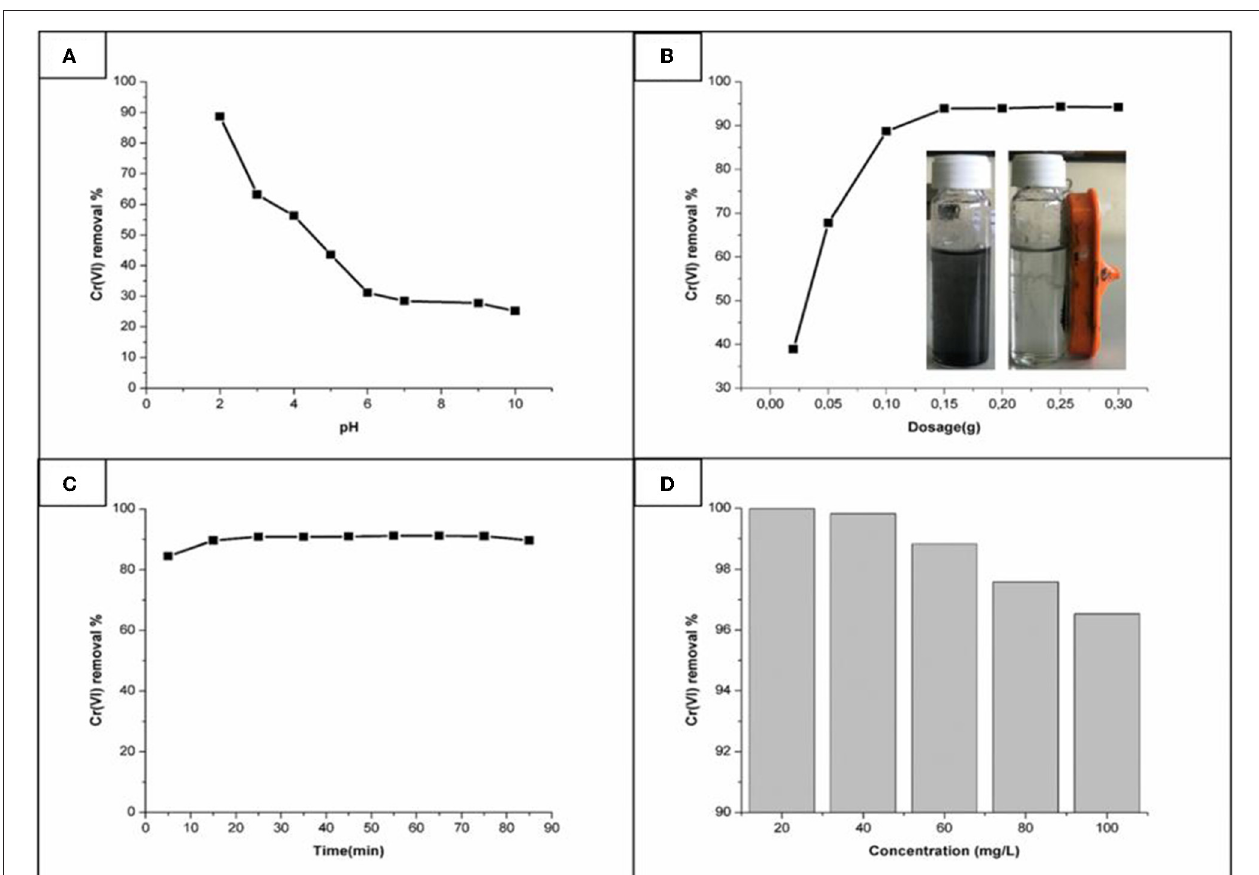
FIGURE 6 | Influence of (A) pH, (B) dosage, (C) time, and (D) concentration on Cr(VI) removal using Fe 3 O 4 /FMO.